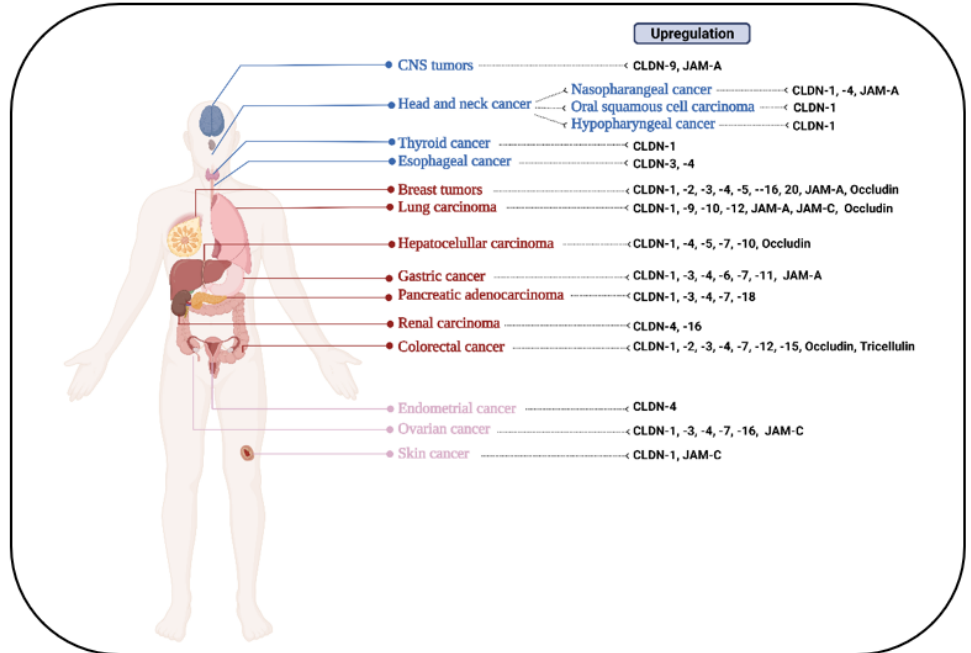
Figure 1. Examples of upregulation of tight junction protein expression in various tumor types. CLDN: claudin; JAM: junction adhesion molecule.